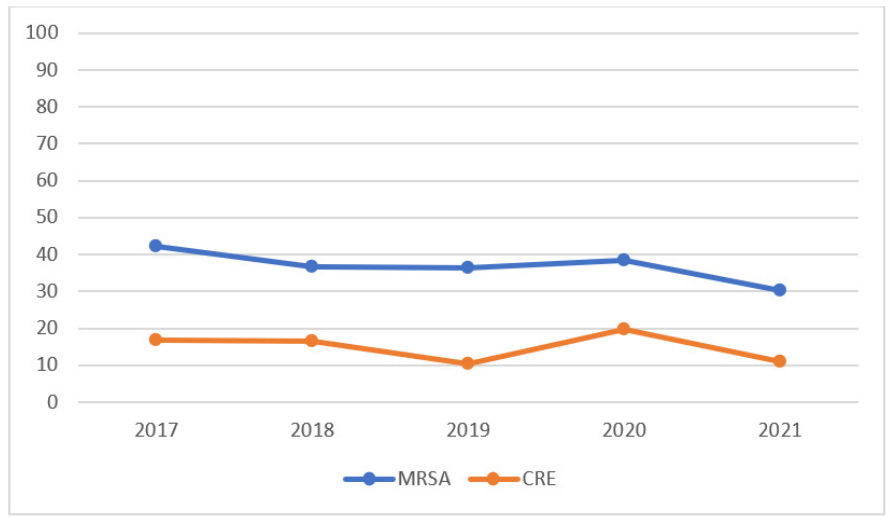
Figure 2. Median methicillin-resistant Staphylococcus aureus (MRSA) and carbapenem-resistant Enterobacteria (CRE) rates among invasive isolates from 27 hospitals in Piedmont, 2017–2021.